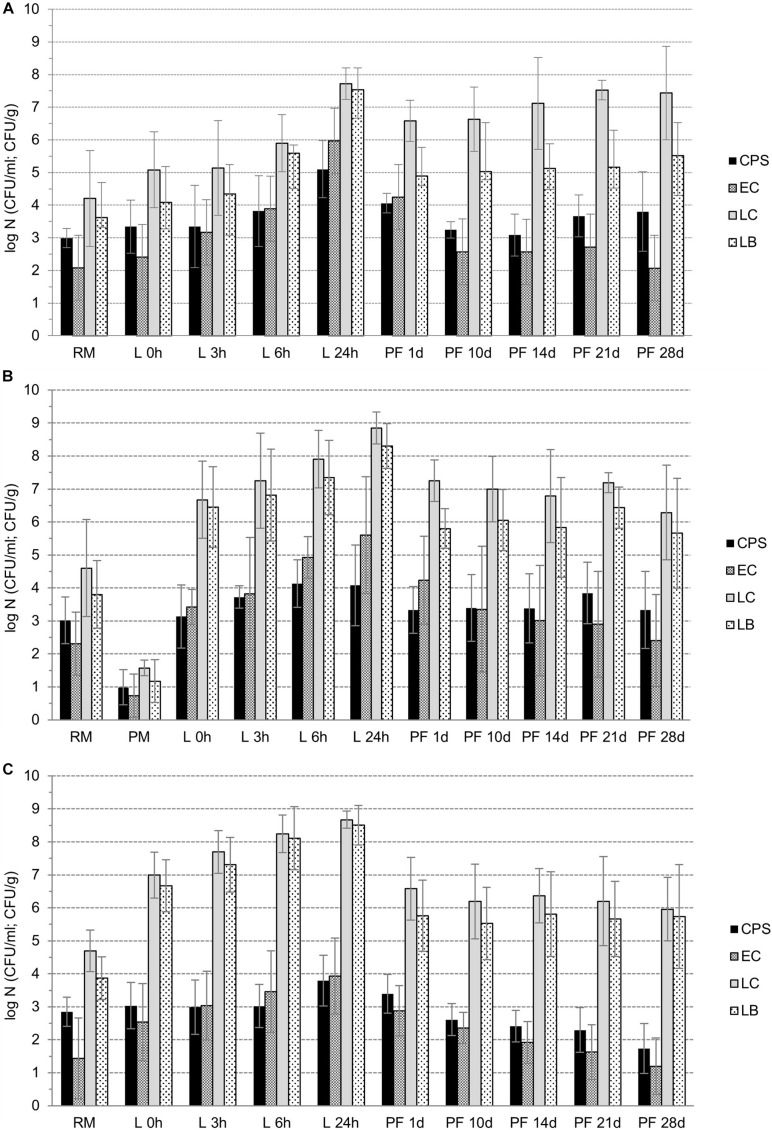
A–C: The counts of selected microbial groups (CPS – coagulase-positive staphylococci, EC – E. coli, P-LC – presumptive counts of lactococci, P-LB – presumptive counts of lactobacilli) during manufacture of pasta-filata cheeses from raw milk (RM) to curd (L 0h), during fermentation of curd (L 3 h, L 6 h, and L 24 h), and during manufacture and storage of pasta-filata cheeses (PF1d – PF28d) at 6 ± 0.5°C for 28 days dependent of various cheese groups (A – CC B – PM, C – RM).